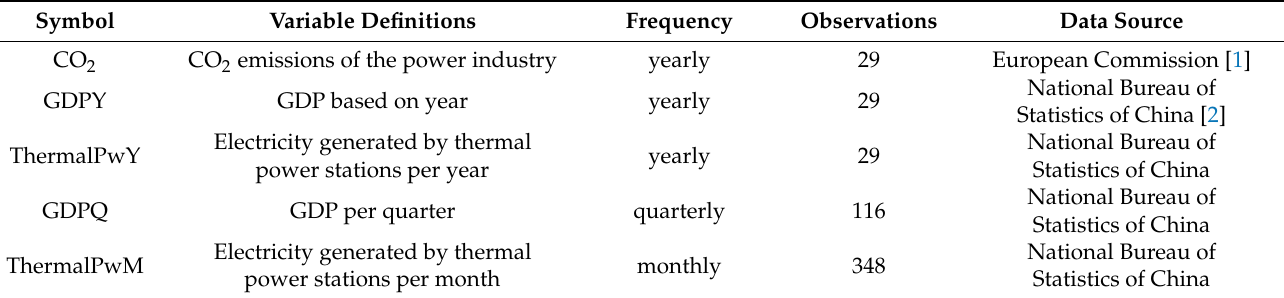
Table 1. Variable definitions and data